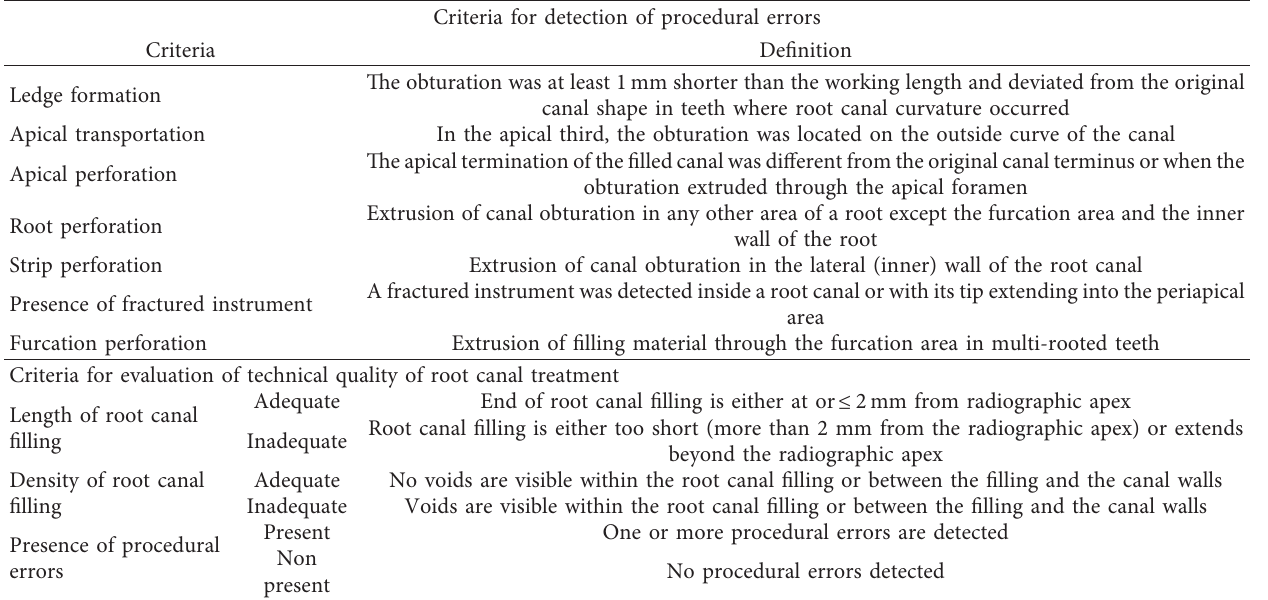
Table 1: Criteria for detection of procedural errors and technical quality of root canal treatment. Criteria for detection of procedural